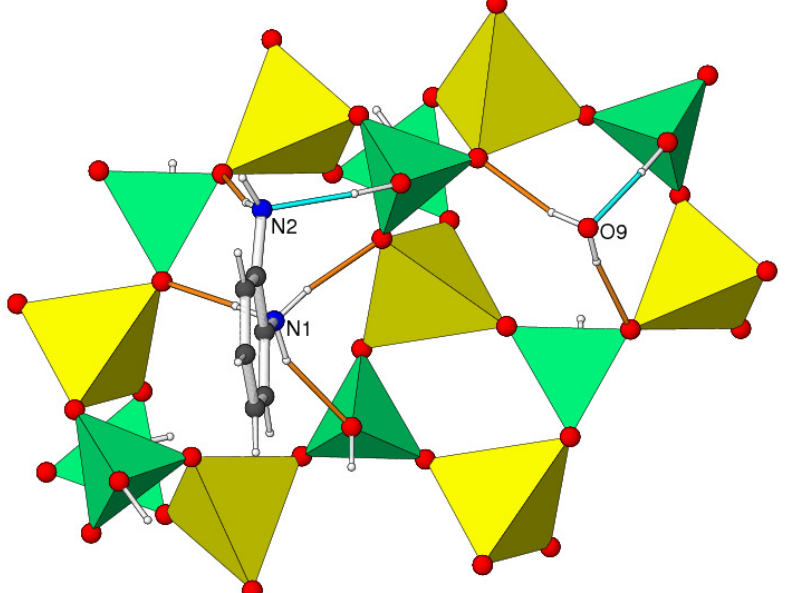
Figure 3. Detail of the structure of 1 showing the framework polyhedral 4-, 6-, and 8-rings and the hydrogen-bond interactions (polyhedral and atom colors as in Figure 2). The N –H L O and O –H L O (t = template, f = framework, w = water) hydrogen bonds are t f w f highlighted in orange; the O –H L O , and O –H L N links are shown in light blue. Crystal f w f t symmetry generates another cation and water molecule below the plane of the tetrahedra with the same hydrogen bonding patterns but these are not shown for